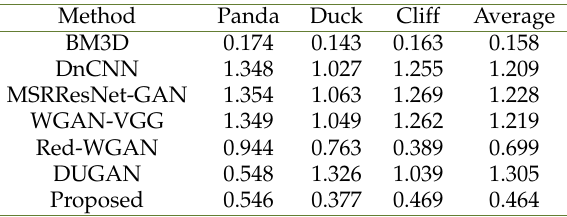
Table 4. Running time with different